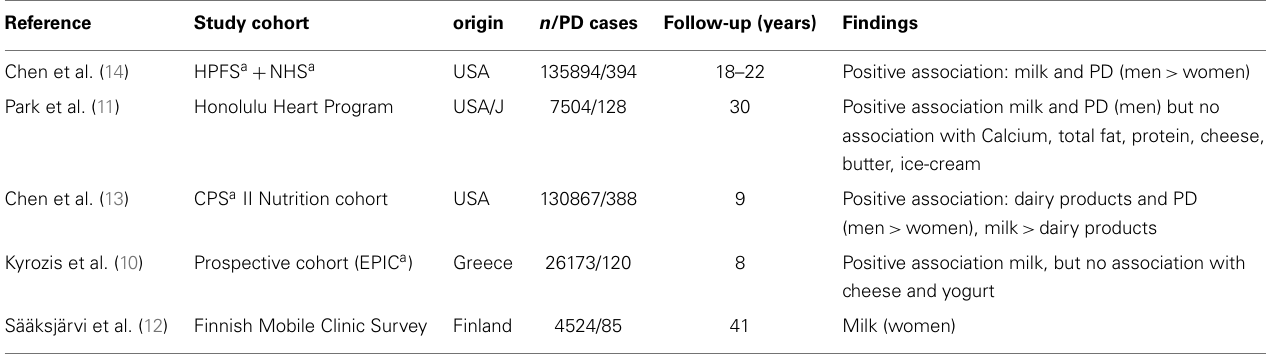
Table 1 | Consumption of dairy products and incidence of PD